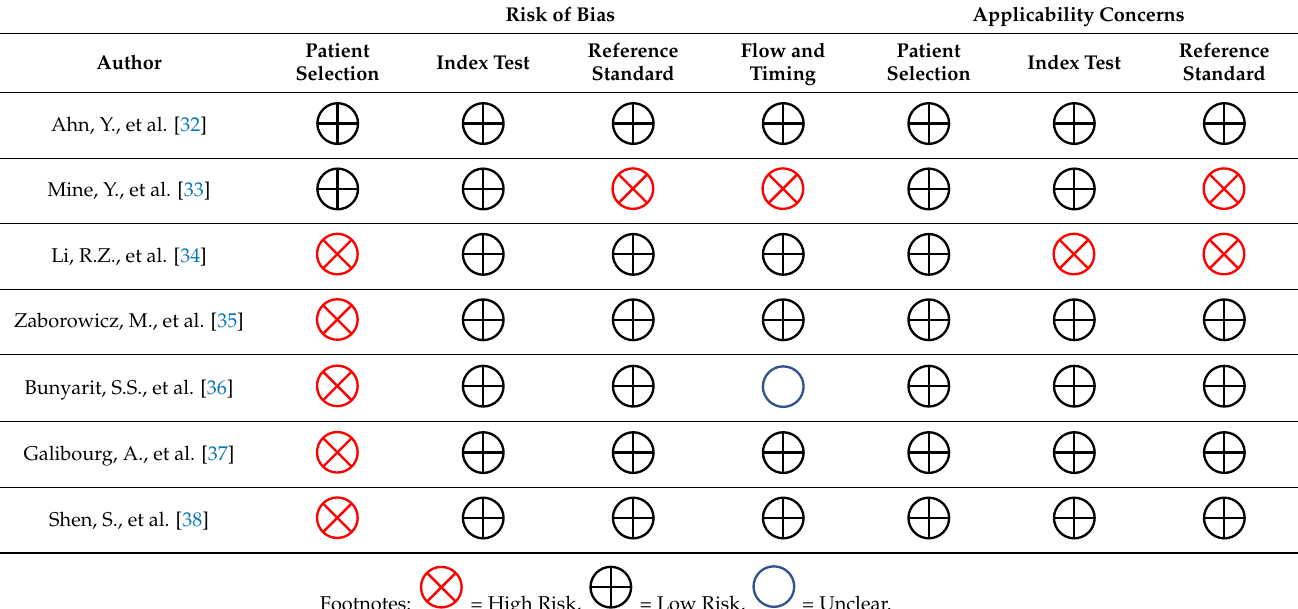
Table A1. S tructured search strategy carried out in electronic databases.